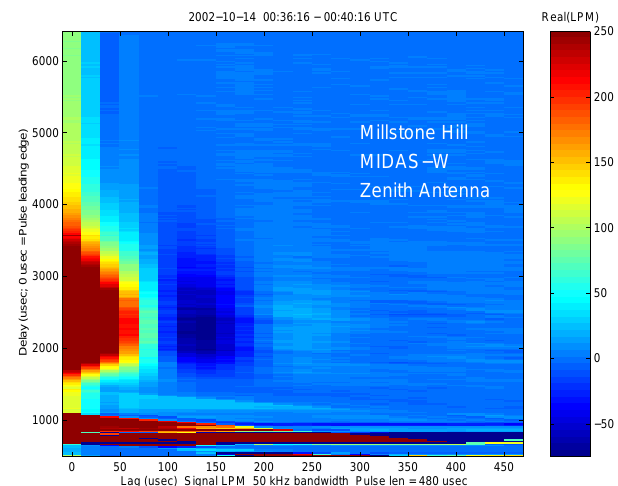
Fig. 6. A typical example of the clutter subtraction process from the Millstone Hill Software Radar implementation. The top plot shows the voltage amplitude of two successive pulses with identical trans- mitted waveforms from an alternating code sequence, containing strong clutter contamination up to delays corresponding to E-region altitudes. The bottom plot shows the result of modified two-pulse clutter subtraction (note the amplitude scale change), demonstrating short range clutter suppression.